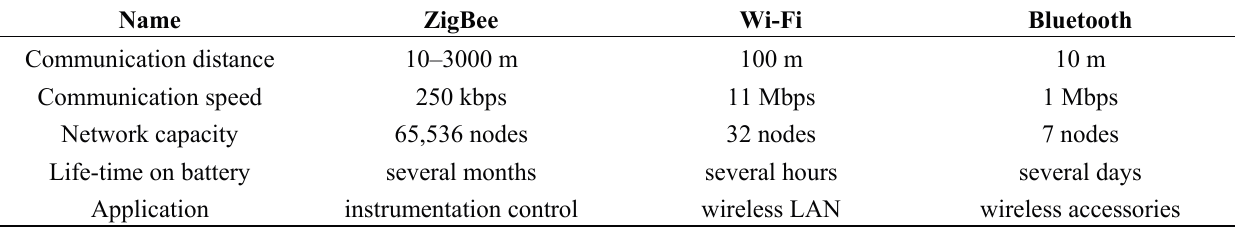
Table 1. Comparison of different communication